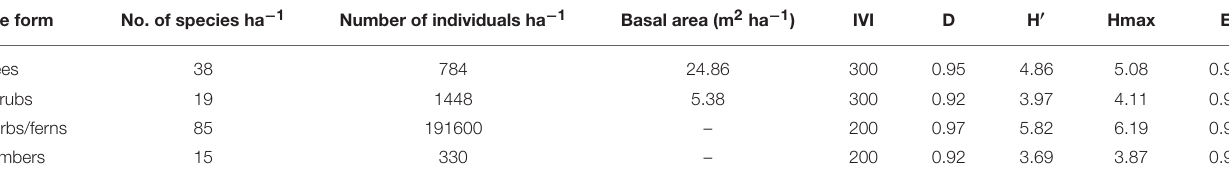
TABLE 2 | Diversity attributes of trees, shrubs, herbs, and ferns and climbers in the broad-leaf coniferous forests of Tshothang Chiwog, Bhutan. Life